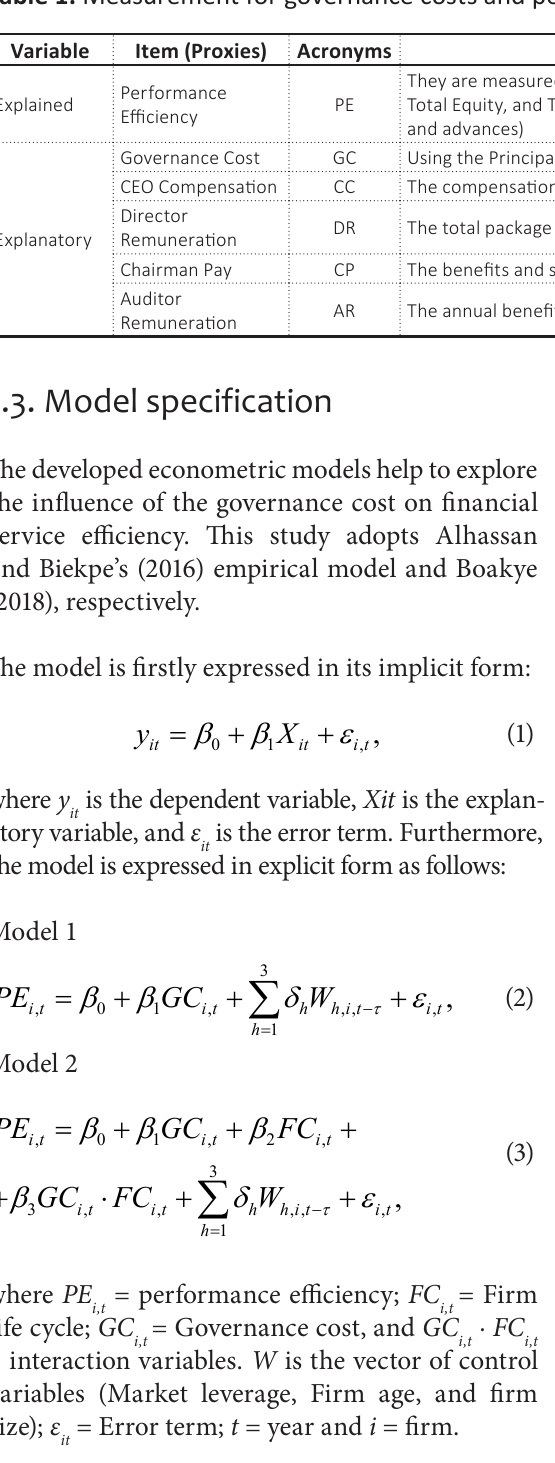
Table 1. Measurement for governance costs and performance